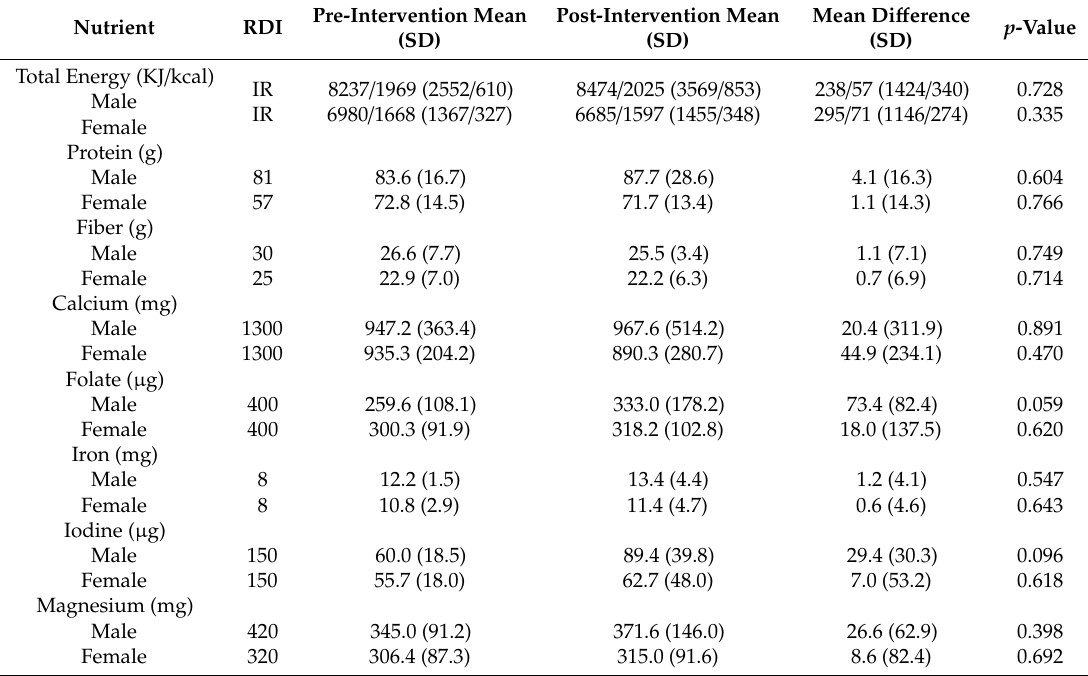
Table 4. Mean nutrient intake for participants at baseline and follow-up appointment. Comparisons were made by two-tailed paired samples t -test. Data shown represents the mean di ff erence and